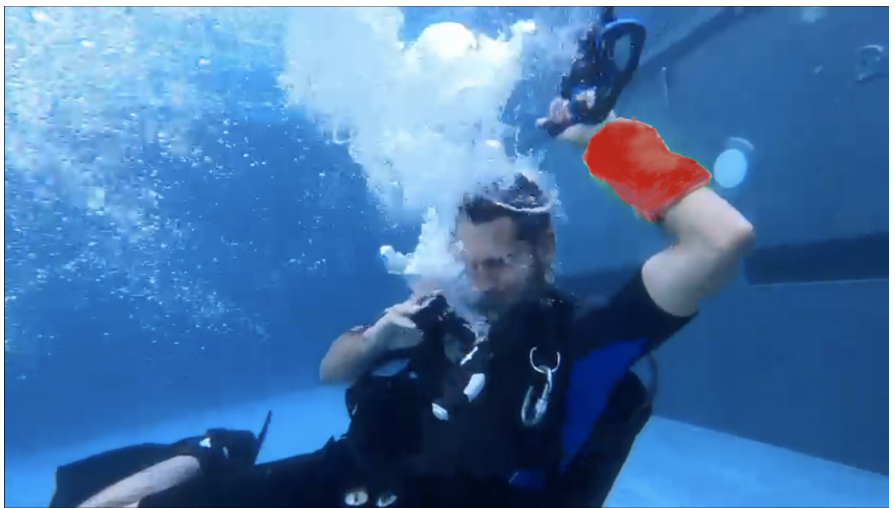
Figure 2. Visual representation of what we envision the system to look like when an alert is generated and